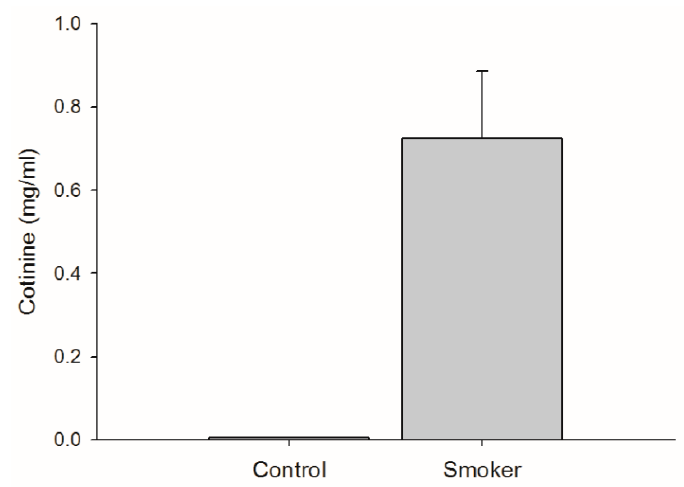
Figure 1. Cotinine content in urine samples from smokers and control subjects. A t-test comparison was done to compare groups and values found to show a statistically significant difference between groups.